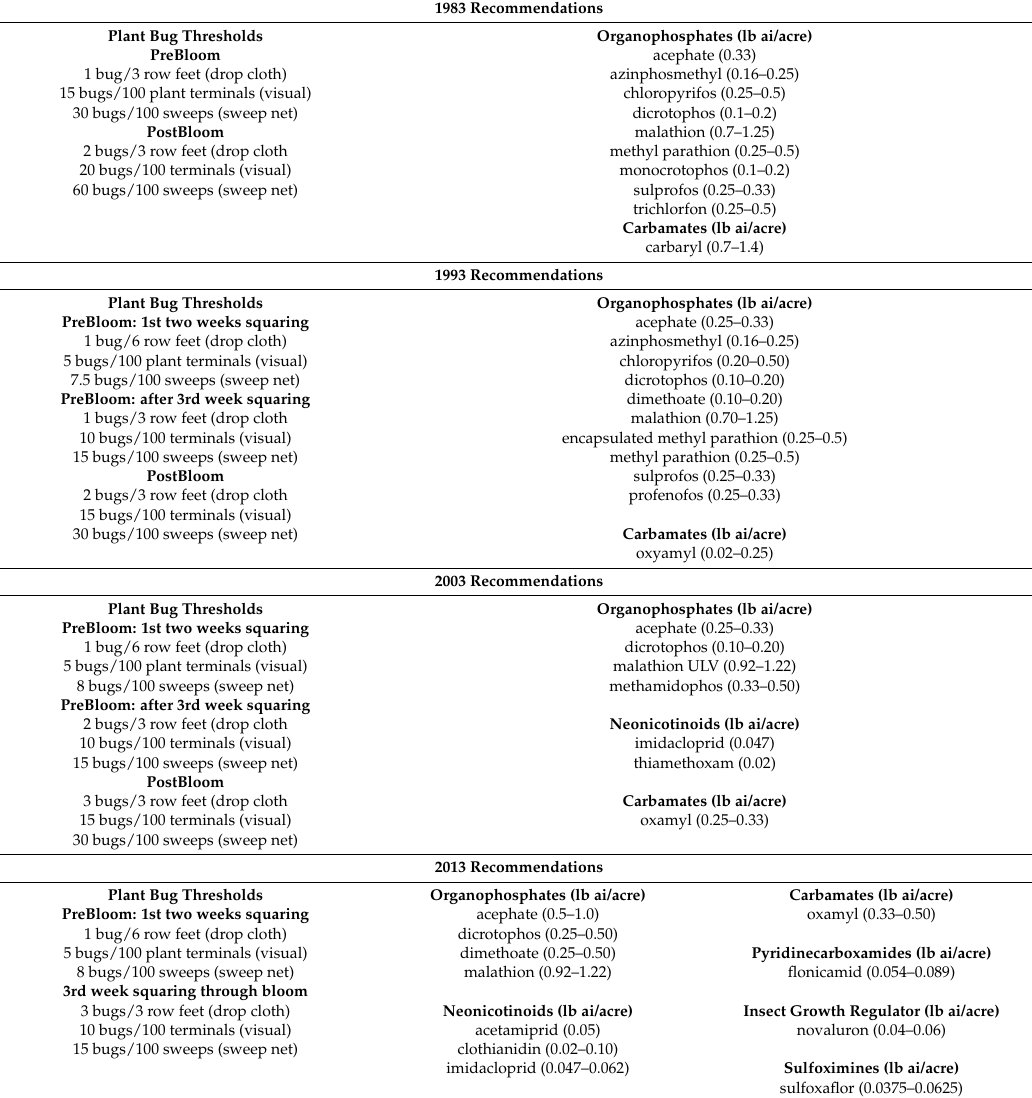
Table 10. Overview of tarnished plant bug thresholds and recommended insecticides by the Mississippi Cooperative Extension Service for 1983, 1993, 2002, and